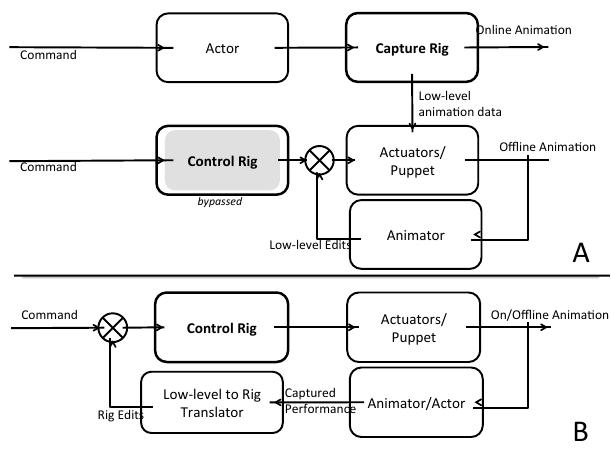
Figure 1. A: In existing workflows, the captured motions are recorded only once by an actor, then edited using low level